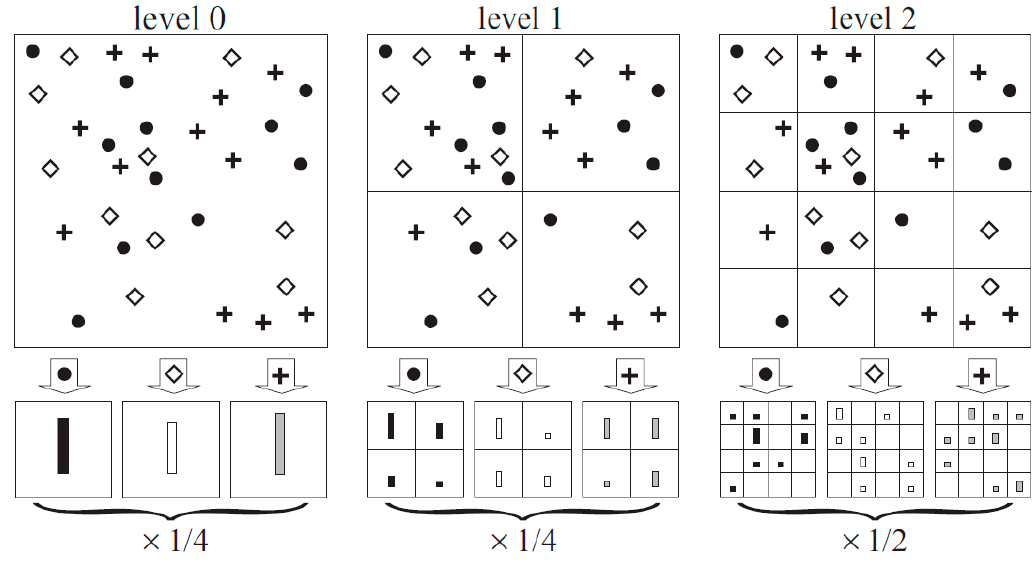
Figure 3. Segmentation in spatial pyramid matching.